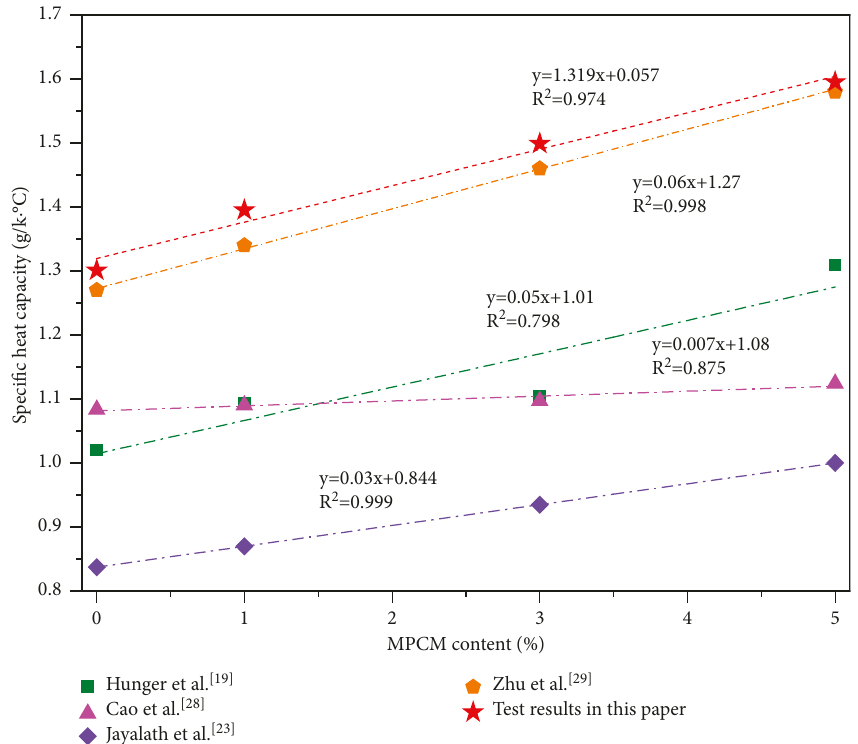
Figure 15: The relation curve between specific heat capacity and MPCM content by different